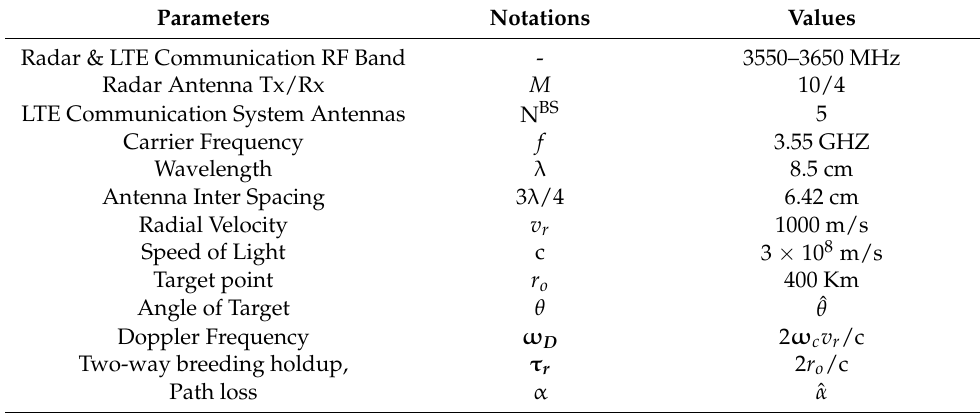
Figure 3. P D when dimension N ( H i ) = 6. And 2.3 to 2.6 dB is needed to achieve 90% of target detection. Table 2. Massive MIMO Radar Parameters for Test